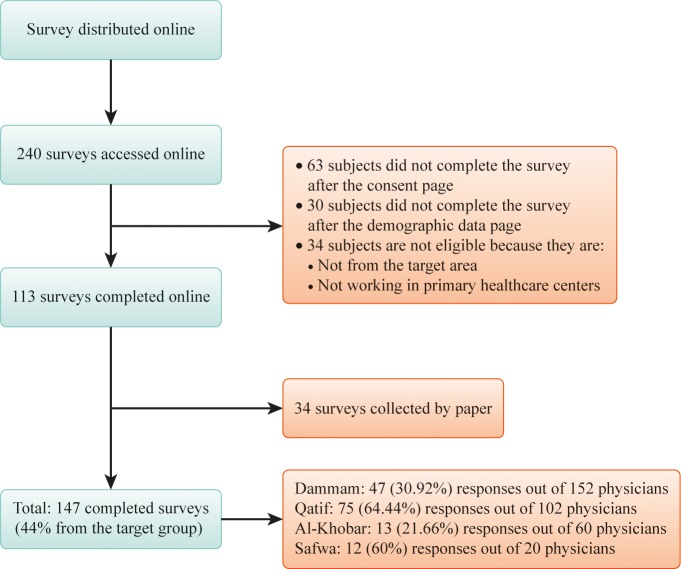
Data collection procedure.